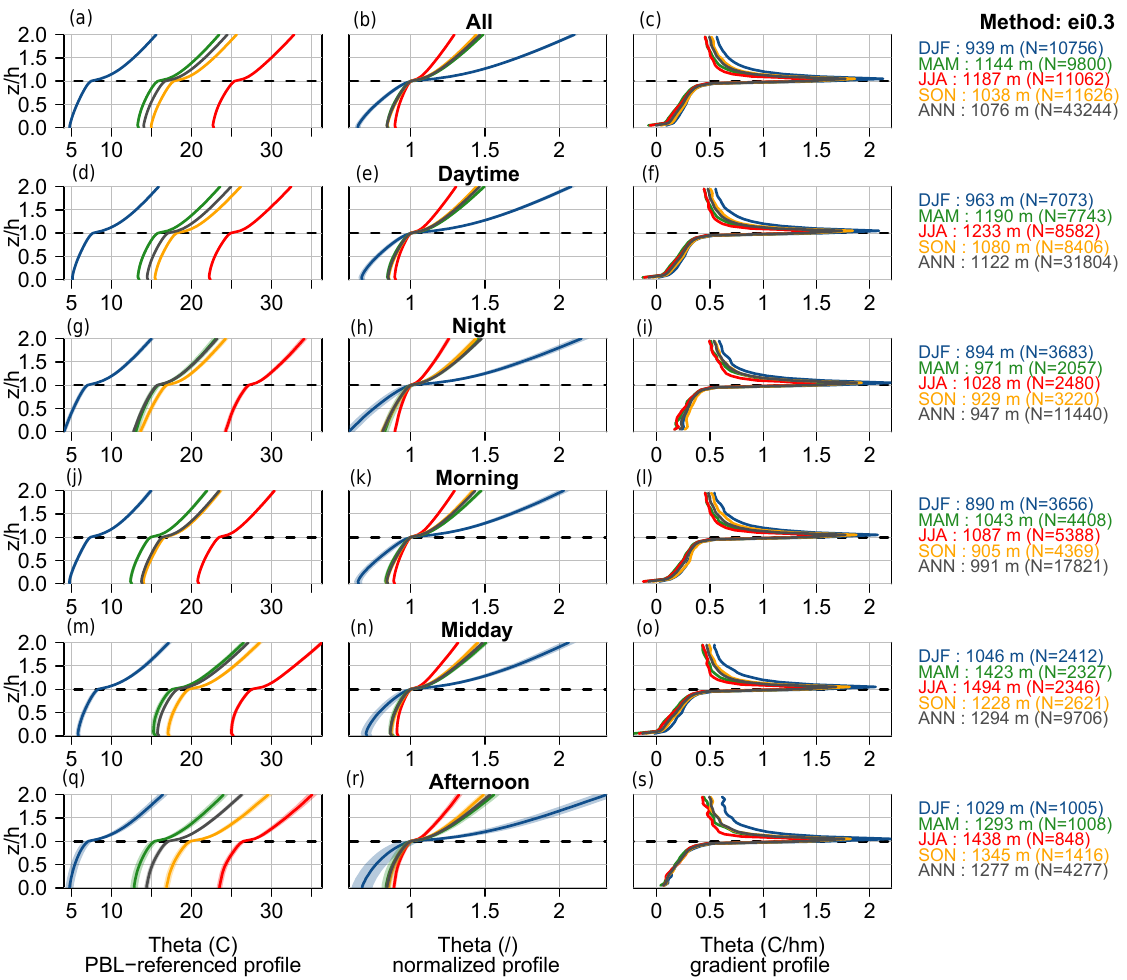
Figure 7. Vertical profiles of potential temperature (in ◦ C; a, d, g, j, m, q ); the same profiles normalized by the potential temperature at z/h = 1 ( b, e, h, k, n, r ) and vertical gradient profiles (in ◦ Chm − 1 ; c, f, i, l, o, s ). Plots are shown for different time slots (from top to bottom: all day, daytime, night-time, morning, midday, afternoon). The shaded area represents the uncertainties (at a 95% confidence level) on the mean. For each season and time of day, we indicate the number ( N ) of profiles used for calculating the PBL-referenced profile (i.e. profiles without any missing data) and the mean PBL height calculated based on this subset of